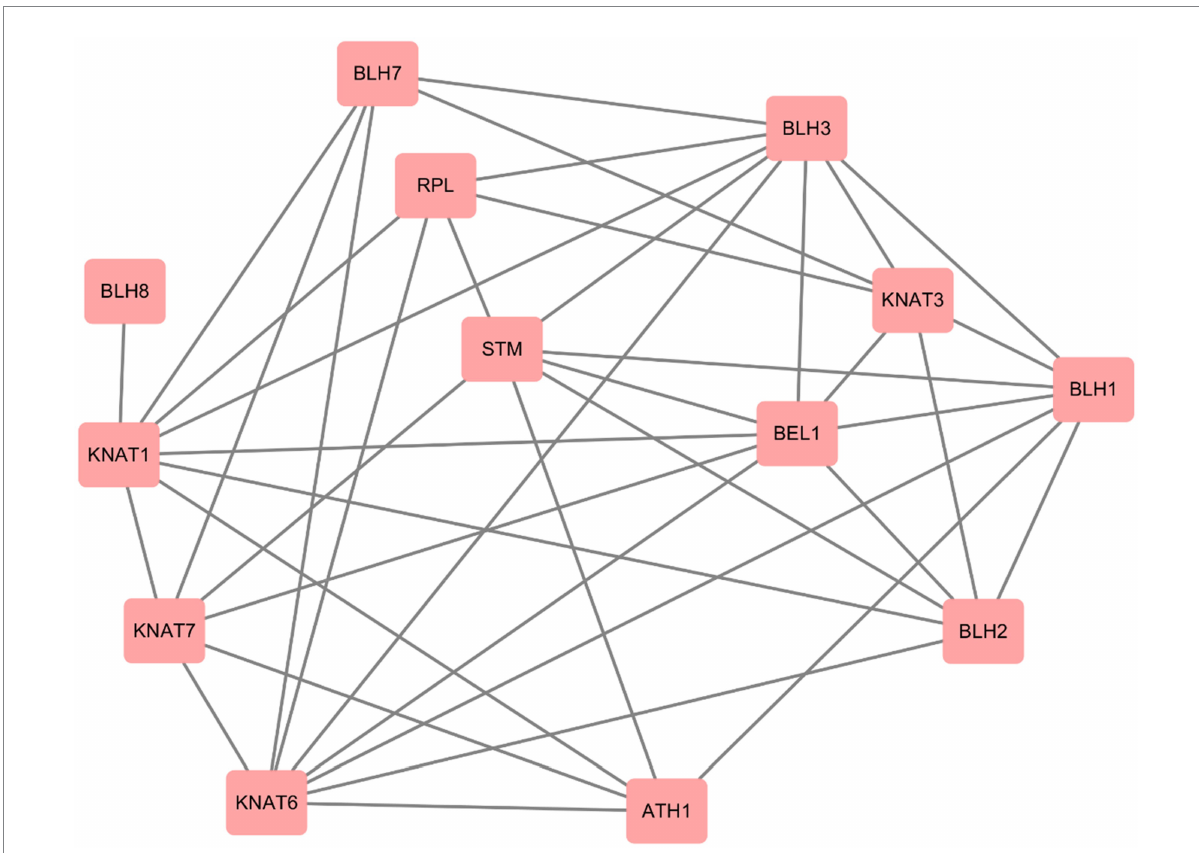
FIGURE 9 Prediction of protein interactions within Prunus mume TALE gene family. STM: PmTALE13, PmTALE14; KNAT1: PmTALE6; KNAT3: PmTALE5, PmTALE22; KNAT6: PmTALE4, PmTALE11, PmTALE12, PmTALE23; KNAT7: PmTALE17; RPL: PmTALE3, PmTALE15; ATH1: PmTALE7; BEL1: PmTALE18; BLH1: PmTALE2, PmTALE20; BLH2: PmTALE21; BLH3: PmTALE9; BLH7: PmTALE16; BLH8: